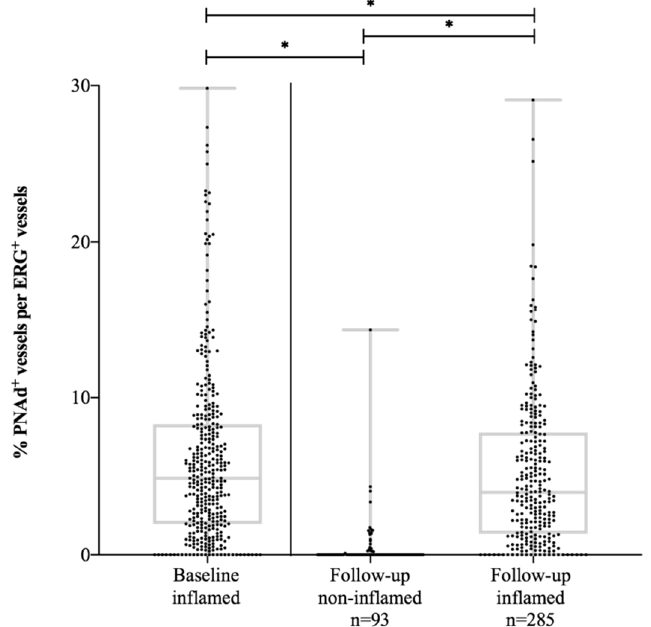
Figure 3. The proportion of PNAd + vessels per ERG + vessels in UC patients at baseline and at follow-up. PNAd, peripheral node addressin; UC, ulcerative colitis. * p-value < 0.05.